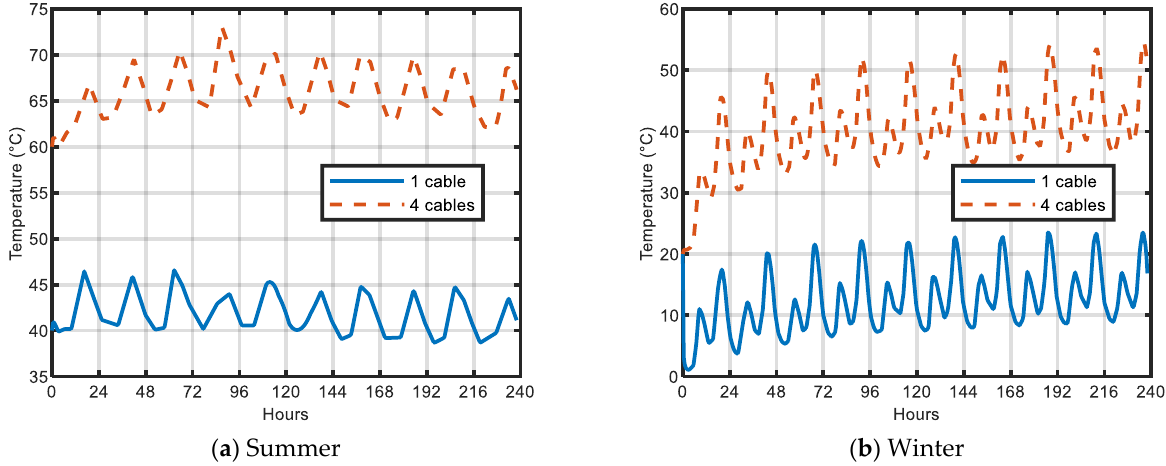
Figure 10. Current flow for one day in each phase of the conductors in summer and winter [32]. These temperature and current data are for one day only. The data were replicated over the ten days to simulate ten days.